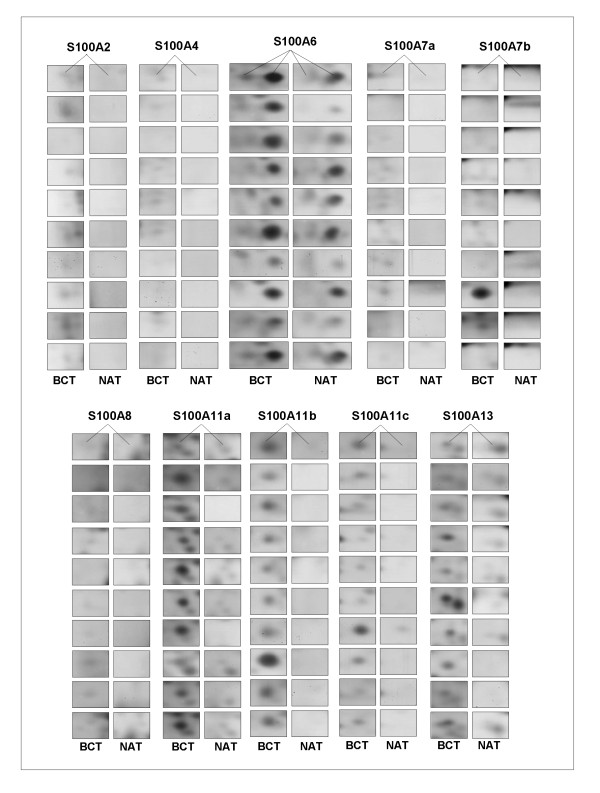
Panel of cropped areas of individual S100 protein spots from matched breast cancer tissues (BCT) and non tumoral adjacent tissues (NAT). The experiments were conducted on a pilot group of 10 patients, selected for the present study.